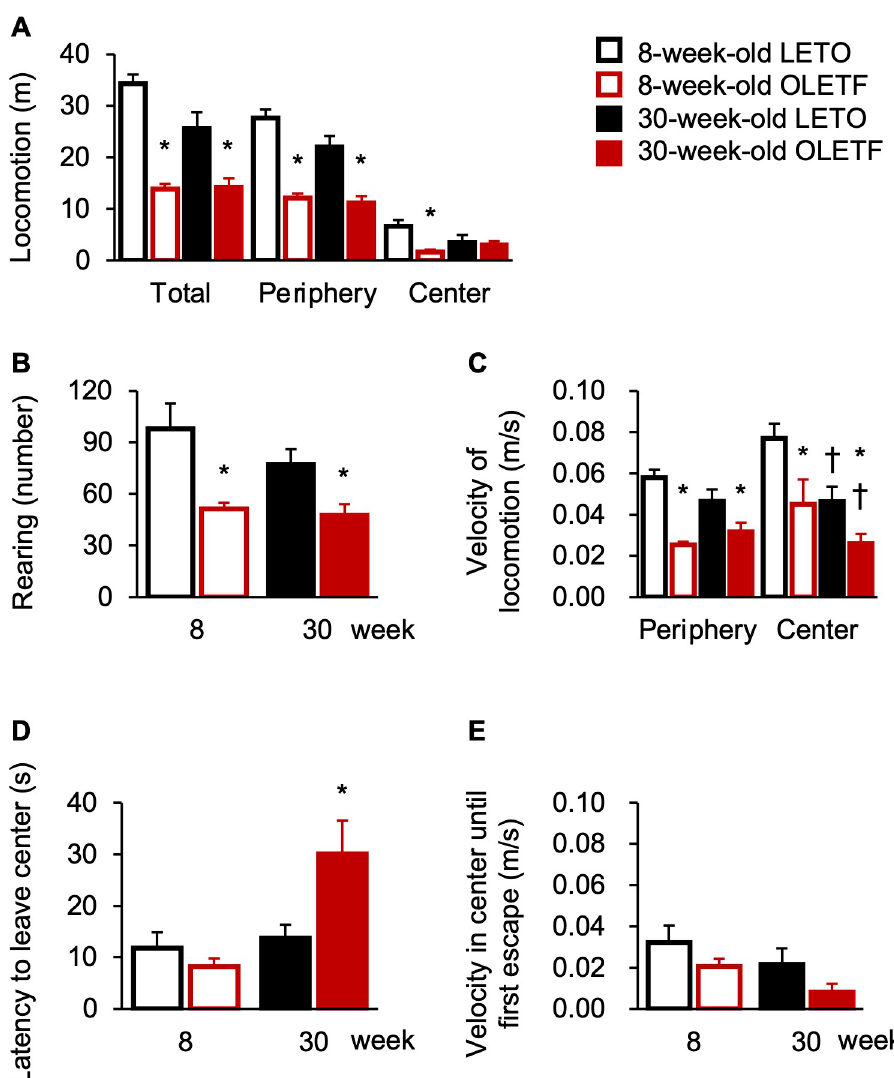
Fig 3. Behavioral assessment in the open field test. Locomotion in each zone ( A ) and number of rearing ( B ). Velocity of locomotive behaviors in each zone ( C ). Latency to leave the center zone ( D ) and velocity in the center zone until first escape ( E ). Values represent mean ± standard error of means. � Significant difference from age-matched LETO rats, p < 0.01, two-way ANOVA. (total zone: F[1, 18] = 51.76, p < 0.01; peripheral zone: F[1, 18] = 65.64, p < 0.01), but there was no significant main effect of age or interaction. The locomotion of OLETF rats in the cen- ter zone was significantly lower than that of rats only at 8 weeks old (Fig 3A), and there was a significant interaction between strain and age (F[1, 18] = 4.49, p < 0.05) and a significant sim- ple main effect of strain at 8 weeks old (F[1, 18] = 10.16, p < 0.01), but not at 30 weeks old. Additionally, the rearing of OLETF rats was significantly less than that of LETO rats regardless of age (Fig 3B), and there was a significant main effect of strain (F[1, 18] = 15.85, p < 0.01), but there was no significant main effect of age or interaction. Based on these results, OLETF rats exhibited fewer locomotive behaviors; therefore, we analyzed non-locomotive behaviors, grooming, and inactivity. Indeed, OLETF rats showed hypolocomotive behaviors at each age.